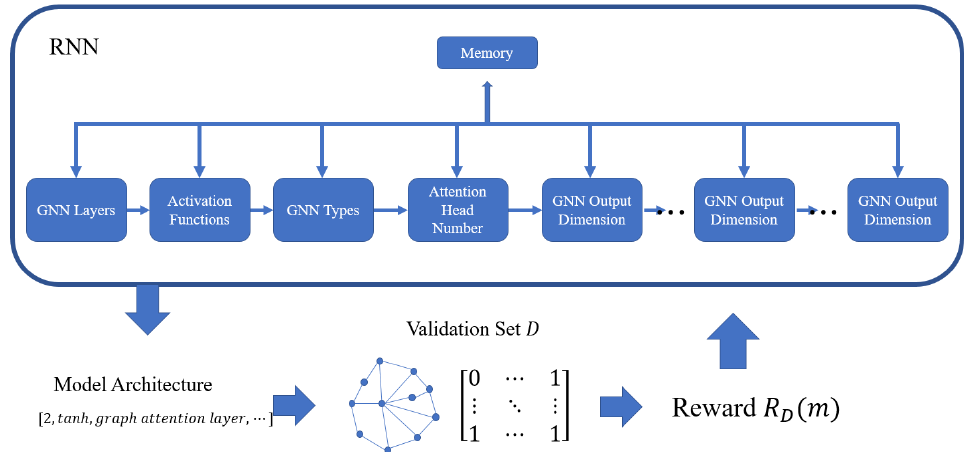
Figure 2. ANAS-HIN algorithm